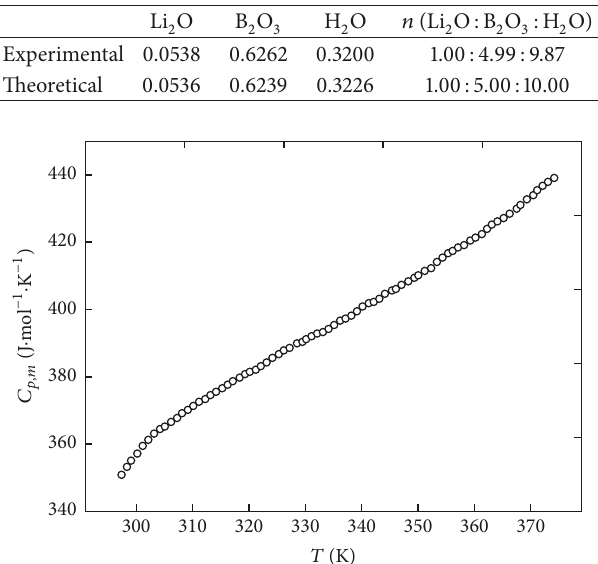
Table 1: Chemical analytical result of lithium pentaborate pentahy- drate in mass fraction.